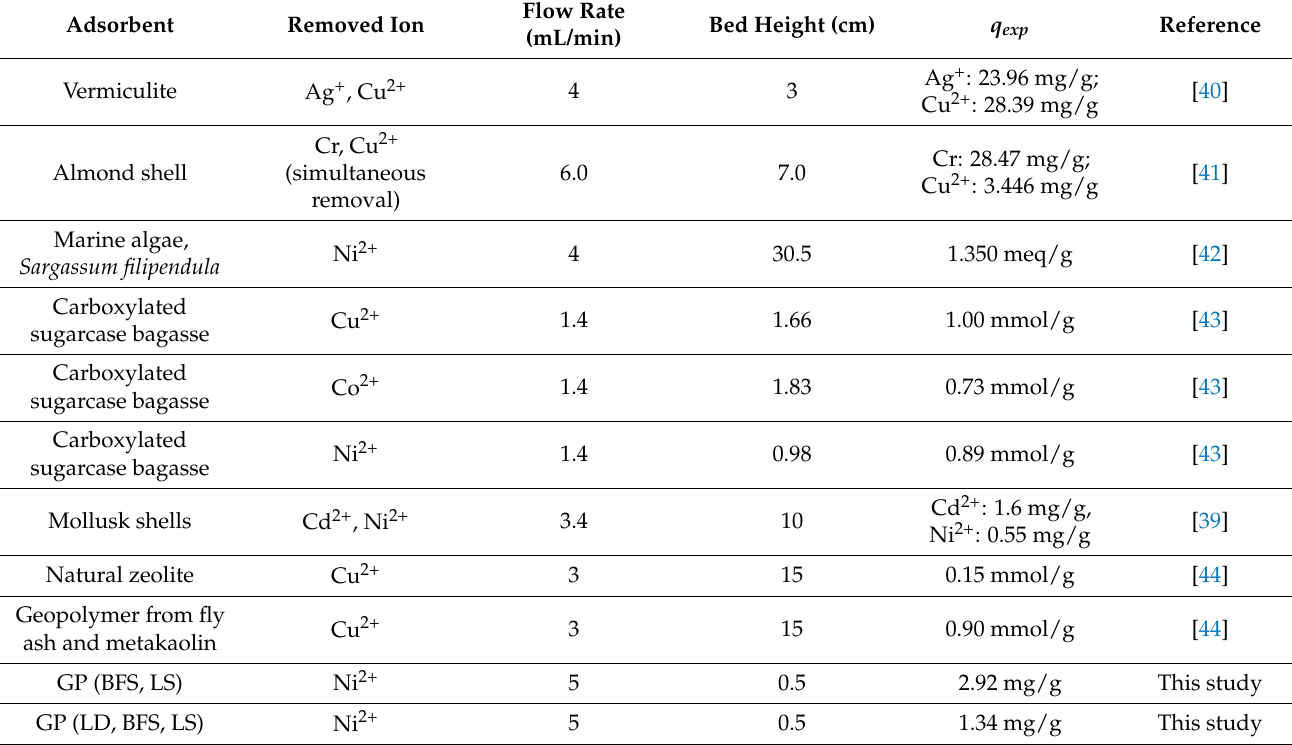
Table 3. Comparison of adsorption capacity of adsorbents to remove different ions in fixed-bed column. Please note that the unit for q exp is presented as in original source (mg/g, mmol/g or meq/g (milliequivalents)).